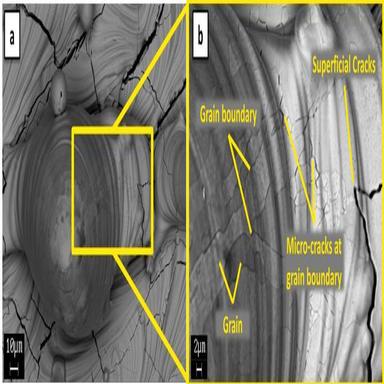
(a) SEM image of a Mo drop produced because of balling effect during SST production; (b) magnification displaying different kinds of cracks.